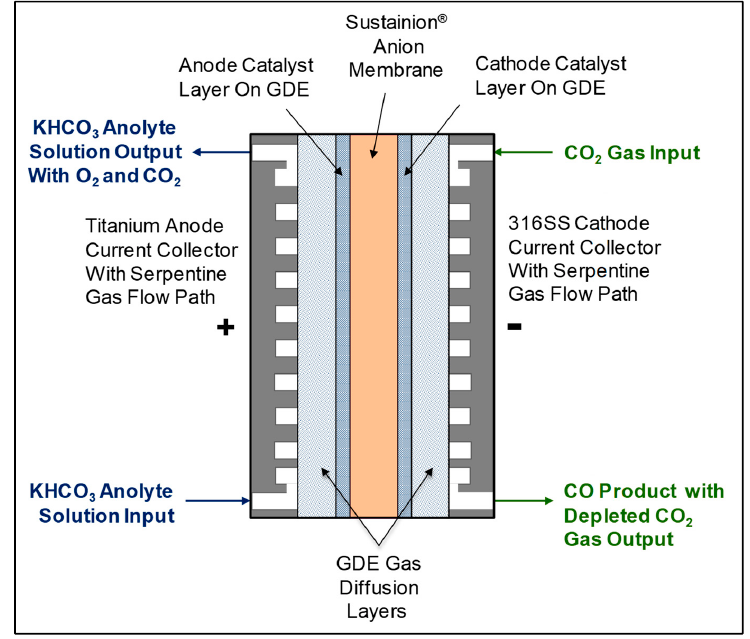
Figure 3. The configuration of a Dioxide Materials single-cell electrolyzer for CO 2 conversion to CO with an active area of 250 cm 2 .